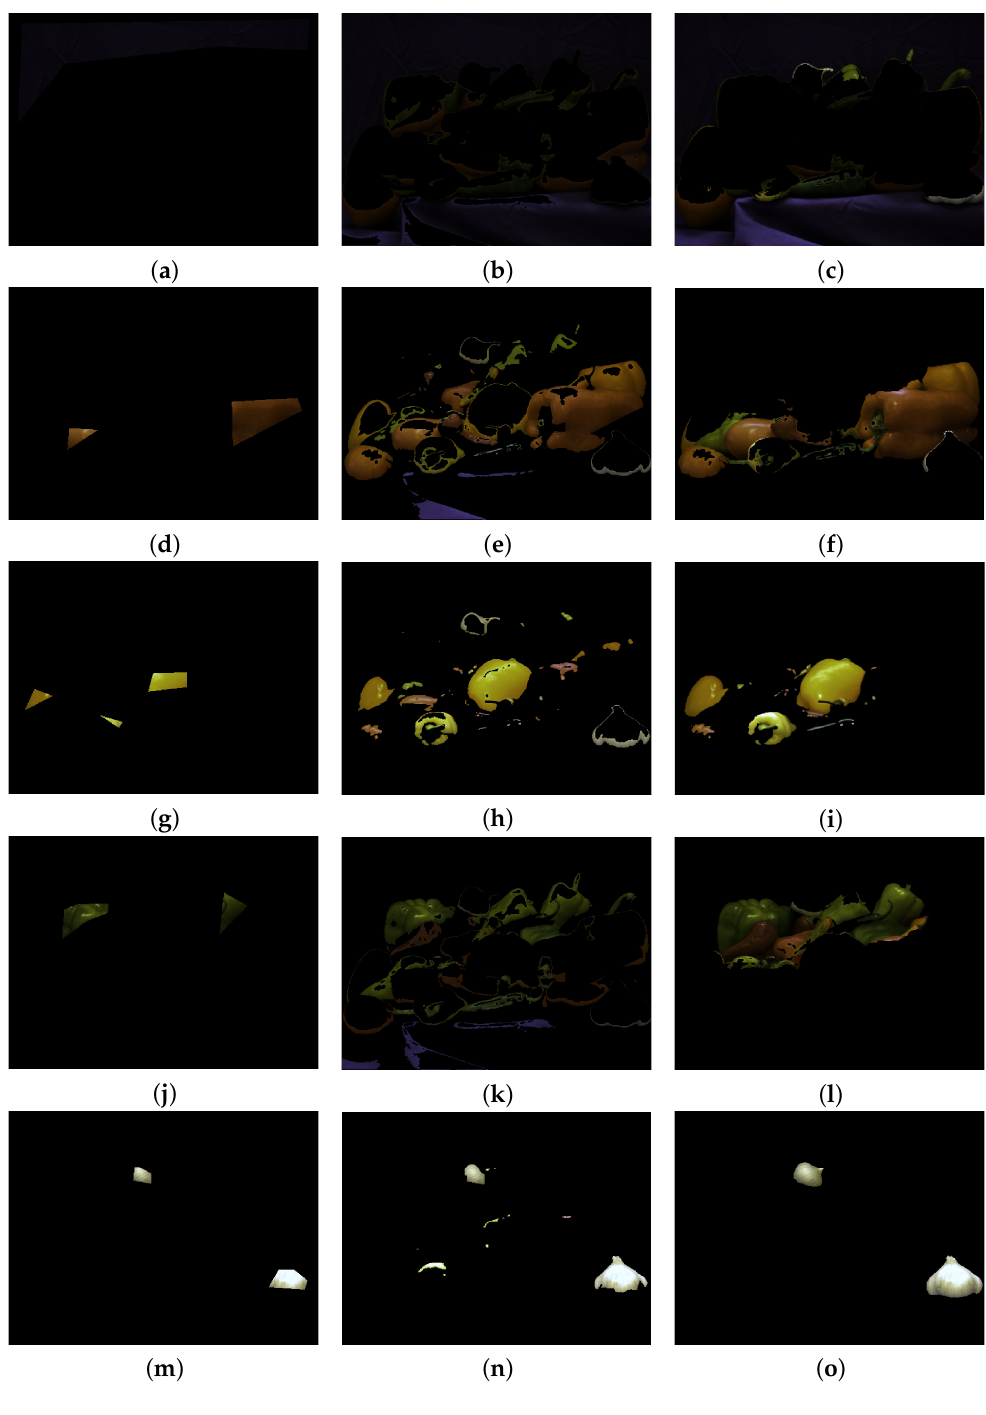
Figure 8. ( a , d , g , j , m ) marked regions, which refers to background, red, yellow, green peppers, and ail and onion, respectively. ( b , e , h , k , n ) labelled region obtained by employing the sole similarity index. ( c , f , i , l , o ) results of the proposed procedure with α = β =